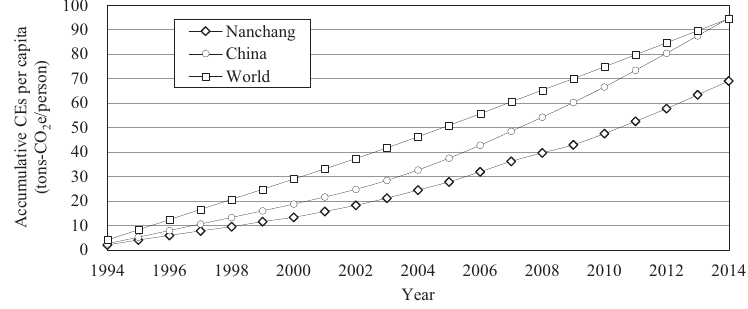
Figure 11. Accumulative CEs per capita for Nanchang, China, and the